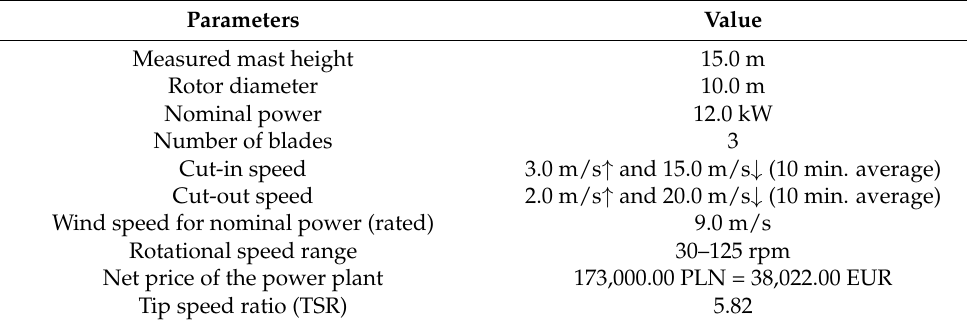
Table 2. Technical specifications of the selected turbine [28].